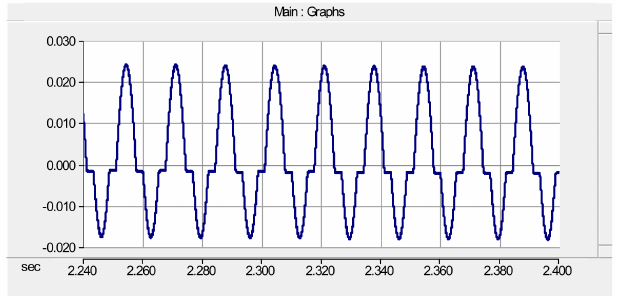
Figure 7. HIF current waveform measured from the neutral line of the main transformer.